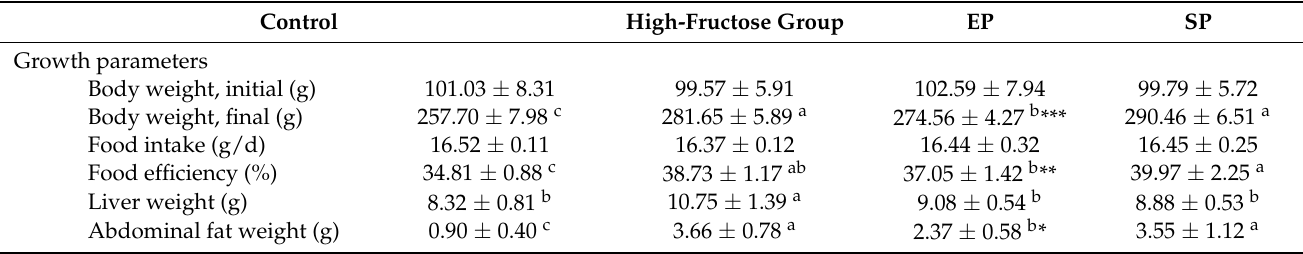
Table 2. Growth paraments and tissue weight in each